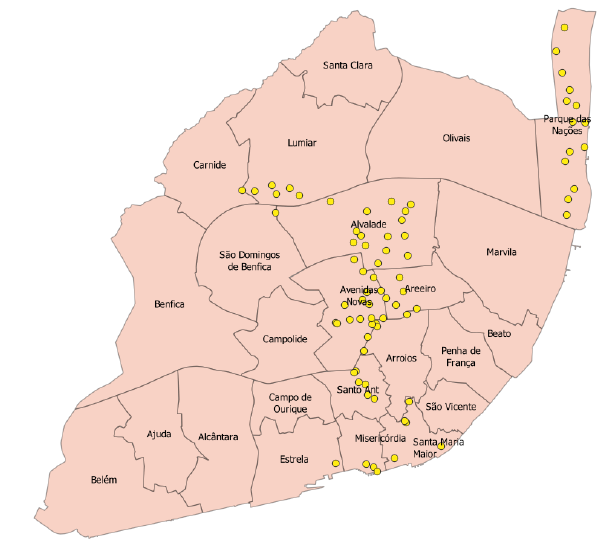
Figure 1. Lisbon bicycles docking stations (yellow dots) distribution over Lisbon city